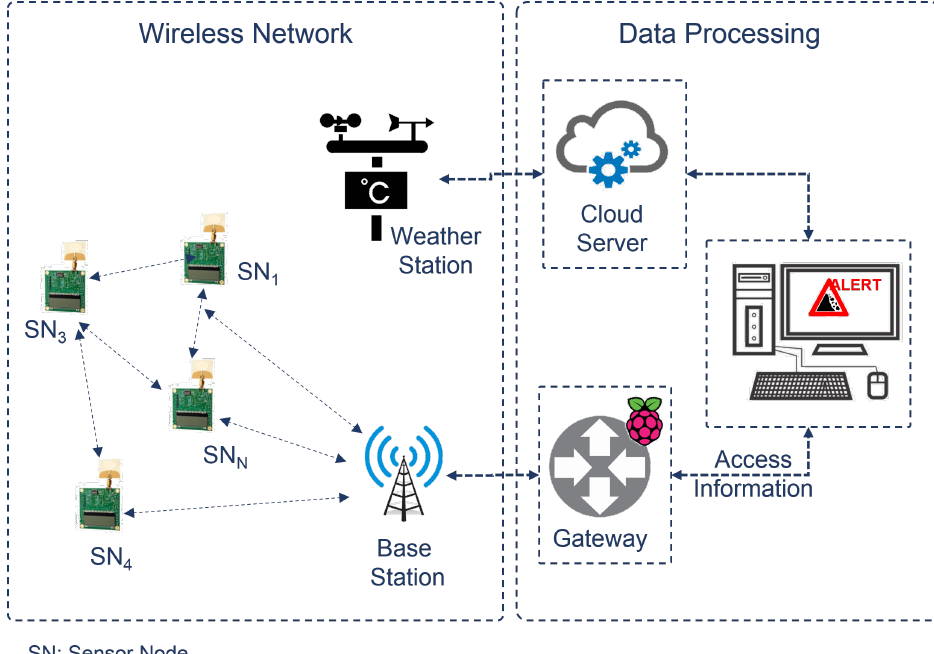
Figure 1. General architecture for the proposed wireless network for landslide early